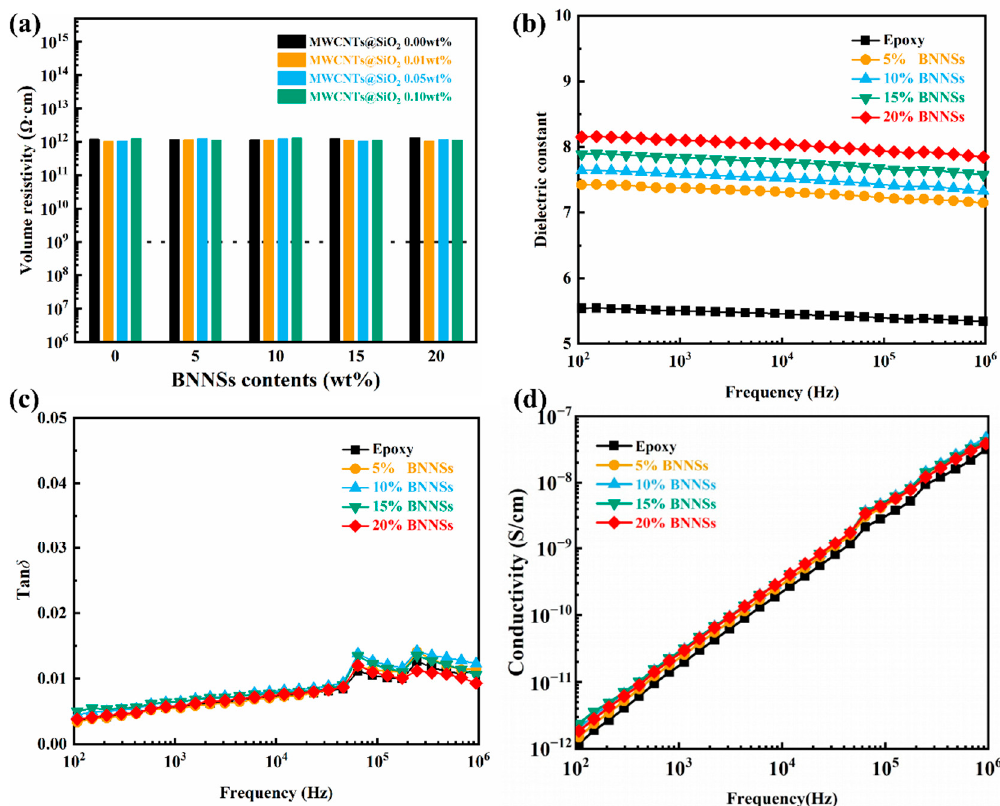
Figure 4. Electrical properties of the BNNSs/MWCNTs@mSiO 2 /epoxy composites. ( a ) Volume resistivity at different MWCNTs@mSiO 2 contents. ( b – d ) Dielectric constants, dielectric loss, and AC conductivity at 0.1 wt% loading of MWCNTs@mSiO 2 as a function of frequency.